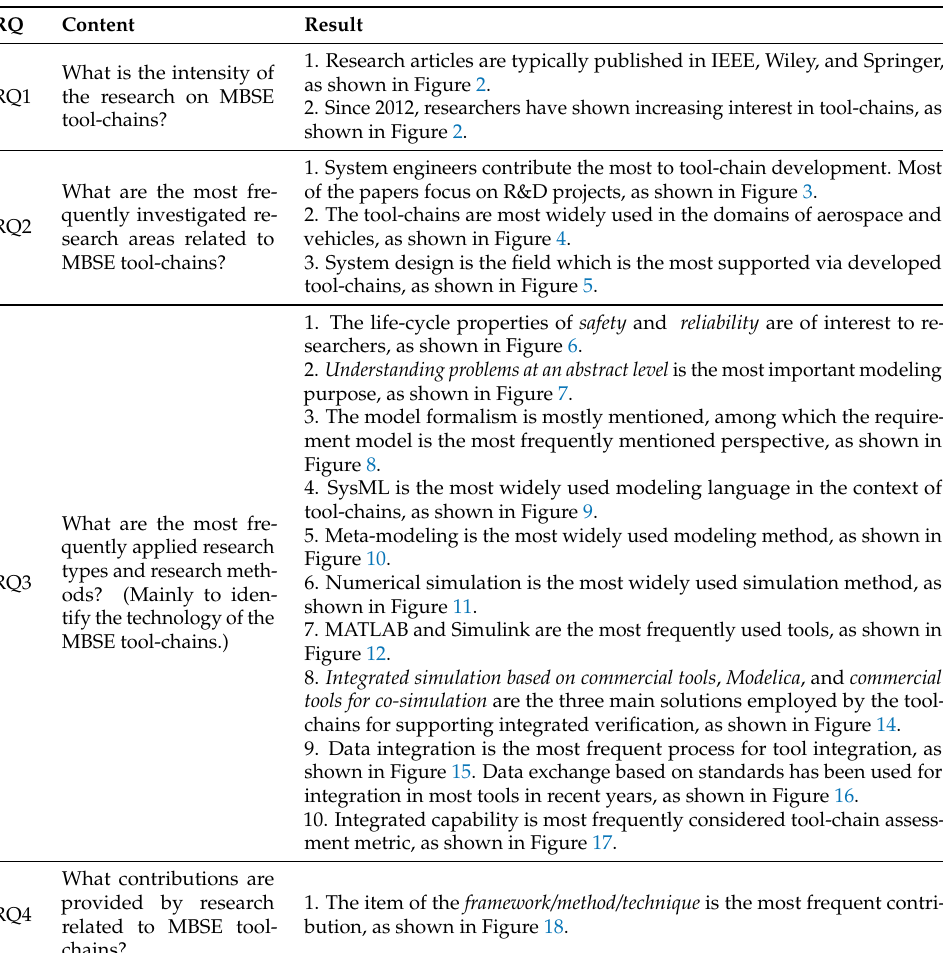
Figure 8. 4. SysML is the most widely used modeling language in the context of tool-chains, as shown in Figure 9. 5. Meta-modeling is the most widely used modeling method, as shown in Figure 10. 6. Numerical simulation is the most widely used simulation method, as shown in Figure 11. 7. MATLAB and Simulink are the most frequently used tools, as shown in Figure 12. 8. Integrated simulation based on commercial tools , Modelica , and commercial tools for co-simulation are the three main solutions employed by the tool- chains for supporting integrated verification, as shown in Figure 14. 9. Data integration is the most frequent process for tool integration, as shown in Figure 15. Data exchange based on standards has been used for integration in most tools in recent years, as shown in Figure 16. 10. Integrated capability is most frequently considered tool-chain assess- ment metric, as shown in Figure